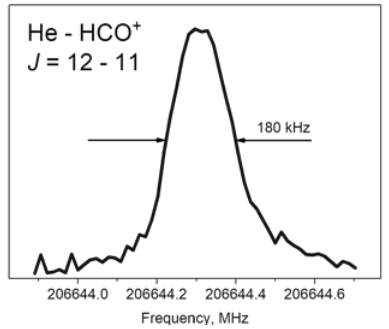
Fig. 4. Example for the double resonance technique applied to the He–HCO +